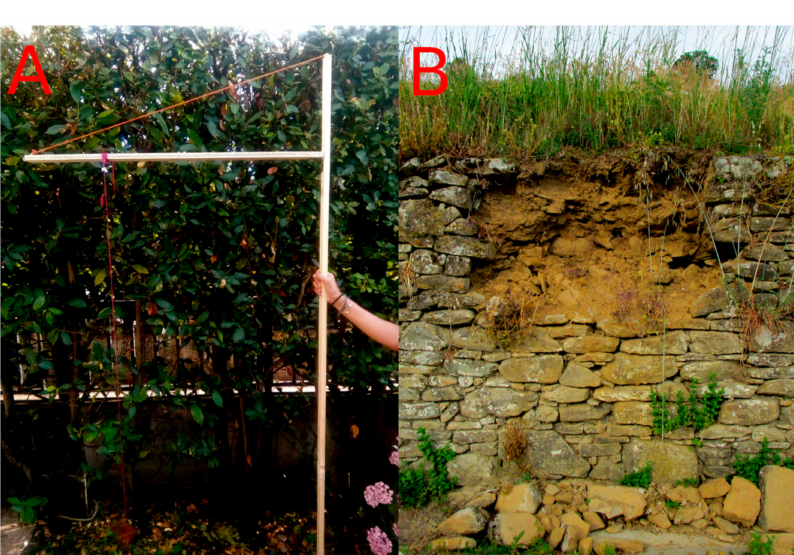
Figure 2. ( A ) Purpose-built instrument to measure deformation consisting of two graduated wooden strips and a plumb line to carry out horizontal measurements and allow the correct positioning of